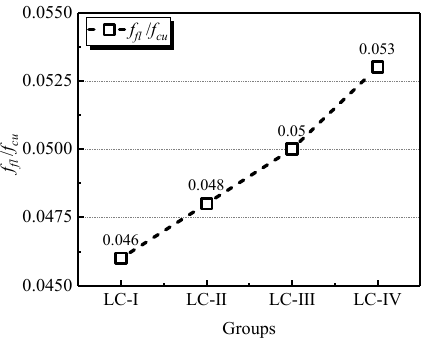
Figure 5. Ratios of the splitting tensile strength to the compressive strength of LC.